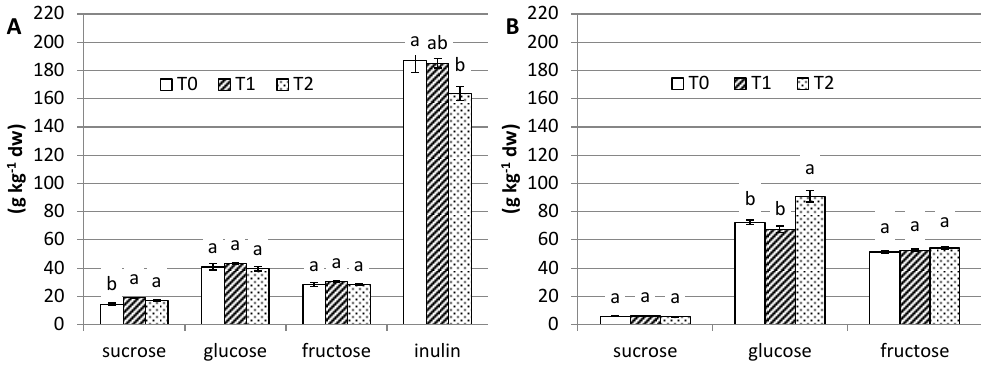
Figure 5. Effect of cutting type used for the vegetative propagation on sugar content in artichoke head ( A ) and leaves ( B ). Within the same trait, data were analyzed by ANOVA, and values with no letter in common are significantly different at p < 0.05, according to Tukey’s HSD Test. Standard errors are